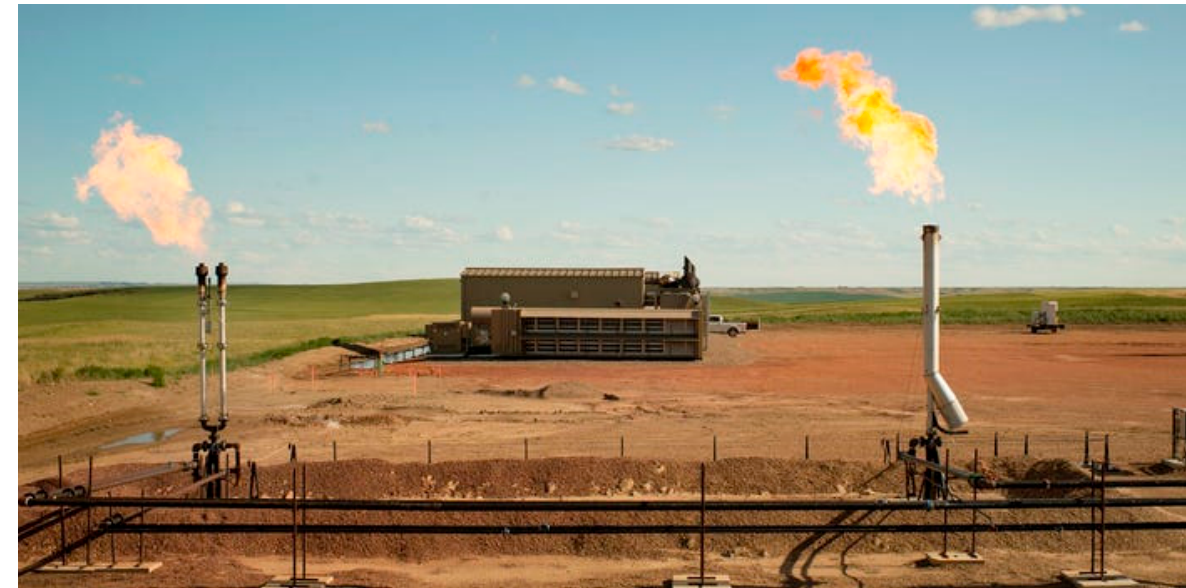
Figure 2. Crusoe Energy’s Flare-mitigation Center in Montana.